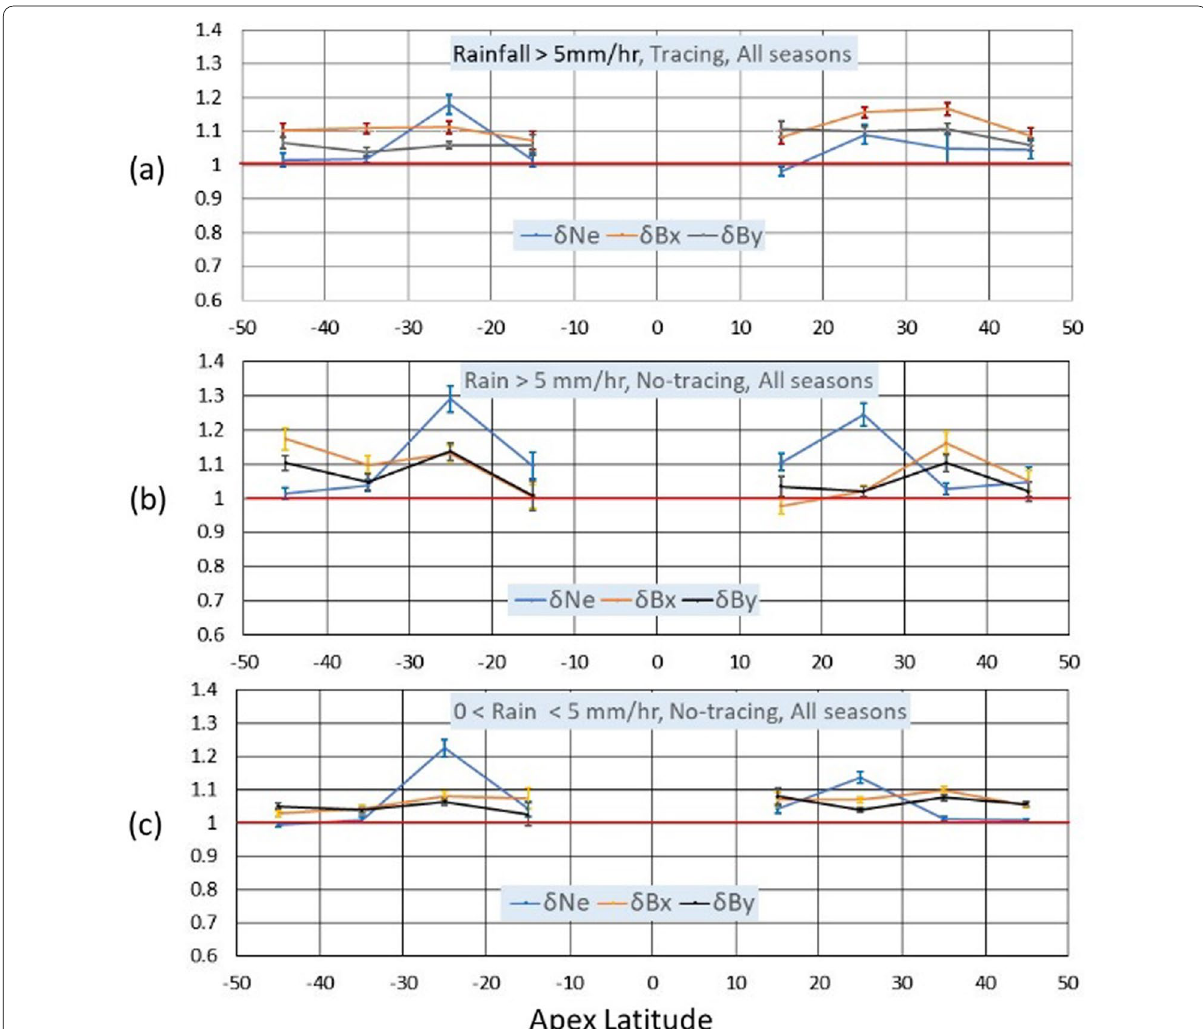
Fig. 11 a Ratio of amplitudes in heavy rainfall (> 5 mm/h) cases to that in no-rain cases at the tracing points P1 and P2 shown in Fig. 1. b Ratio for heavy rainfall cases at the geodetic latitude and longitude of the satellite location, i.e., the GSMaP data vertically below the satellite, P0 in Fig. 1 are used. c Same as b , but under weak rainfall (i.e., 0 < rainfall < 5 mm/h)